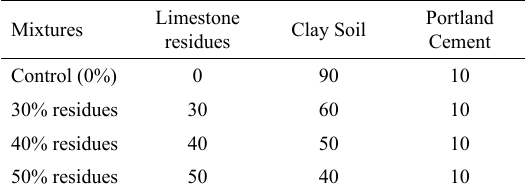
Table 1. Compositions (vol%) of the soil-cement mixtures Limestone Mixtures residues